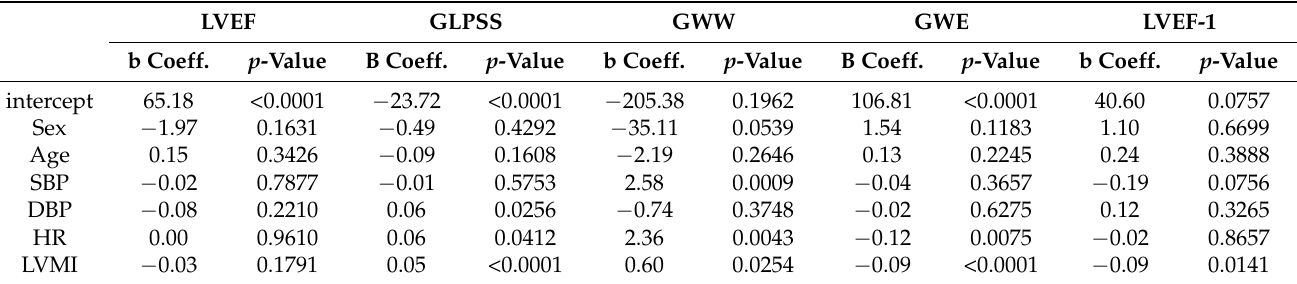
Table 4. Multivariate linear regression for the association of LV systolic function parameters with sex, gender, heart rate, blood pressure and LV mass